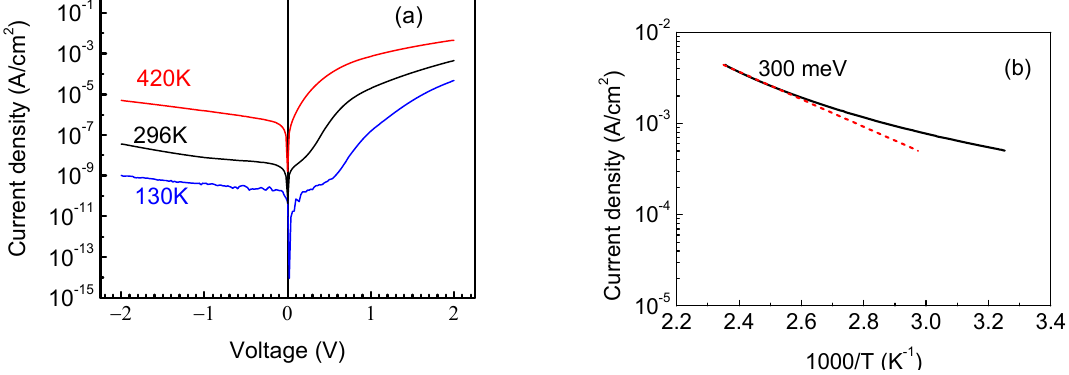
Figure 8. ( a ) I-V characteristics at three different temperatures; ( b ) the temperature dependence of forward current at +2 V.